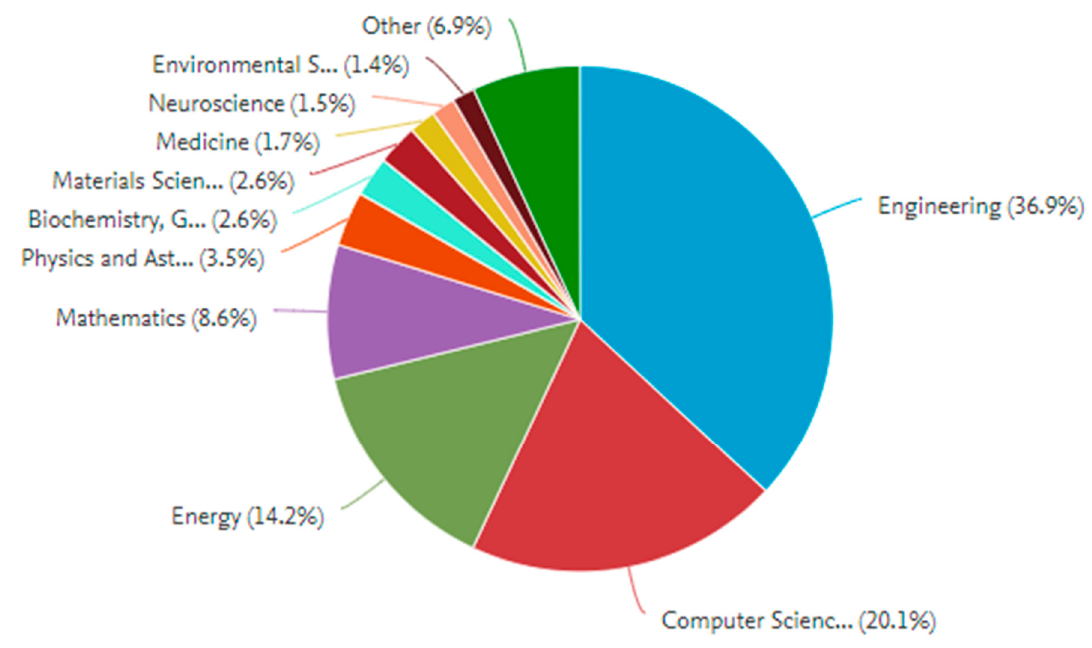
Figure 8. The subject area of rotating electrical machines using soft computing, from 1987–2017. The math, computer science, and energy subject areas had a rise (Source: Scopus & Web of Science).